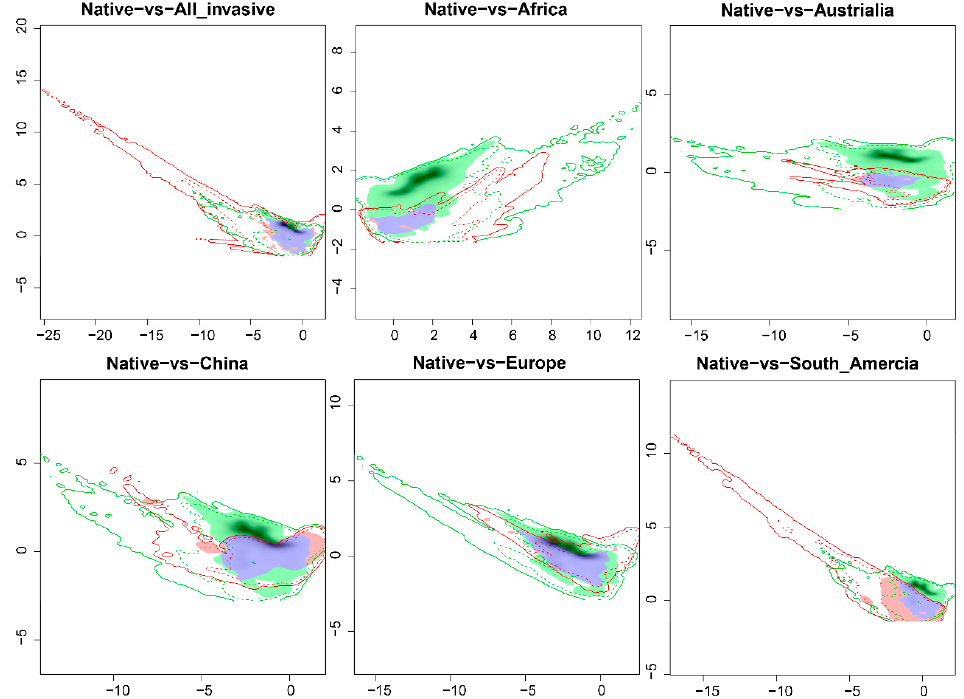
Figure 2. Projection of the native (green) and invasive regions (red) realized niches of Ambrosia artemisiifolia in climatic space, represented by the first two axes of principal component analysis. Contours represent 100% (solid line) and 50% (dotted line) of the available climatic space within each range (green native, red invasive). Unfilled, stable, and expanded niches are represented by green, blue, and red shades, respectively. The gray shading shows the smoothed occurrence density in the native niche space and in the exotic niche